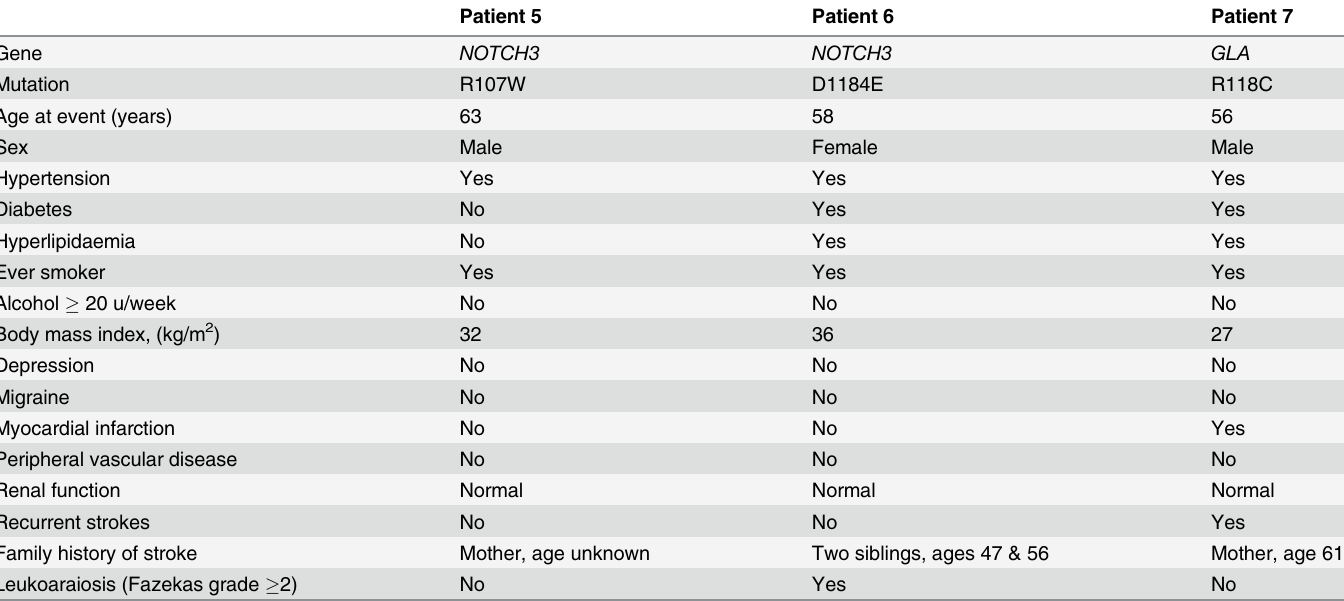
Table 3. Clinical characteristics of cases with genetic variants of unknown significance.